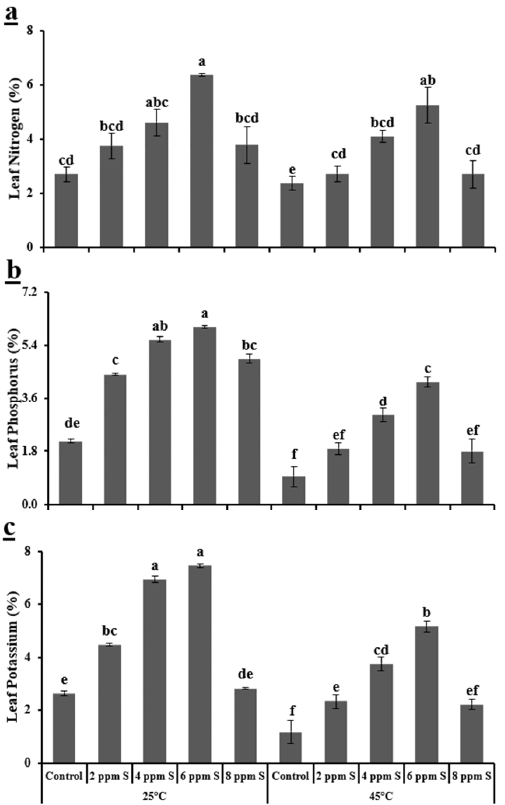
Figure 4. Leaf mineral concentrations [i.e., Nitrogen ( a ), Phosphorus ( b ), Potassium ( c )] of tomato plants (cv. Roma) as affected by temperature and exogenous application of S. Same letters indicate non-significant differences among treatments according to Tukey’s honestly significant difference test ( p ≤ 0.05). Vertical bars indicate averages ± standard errors ( n = 4, 5 plants per replicate).